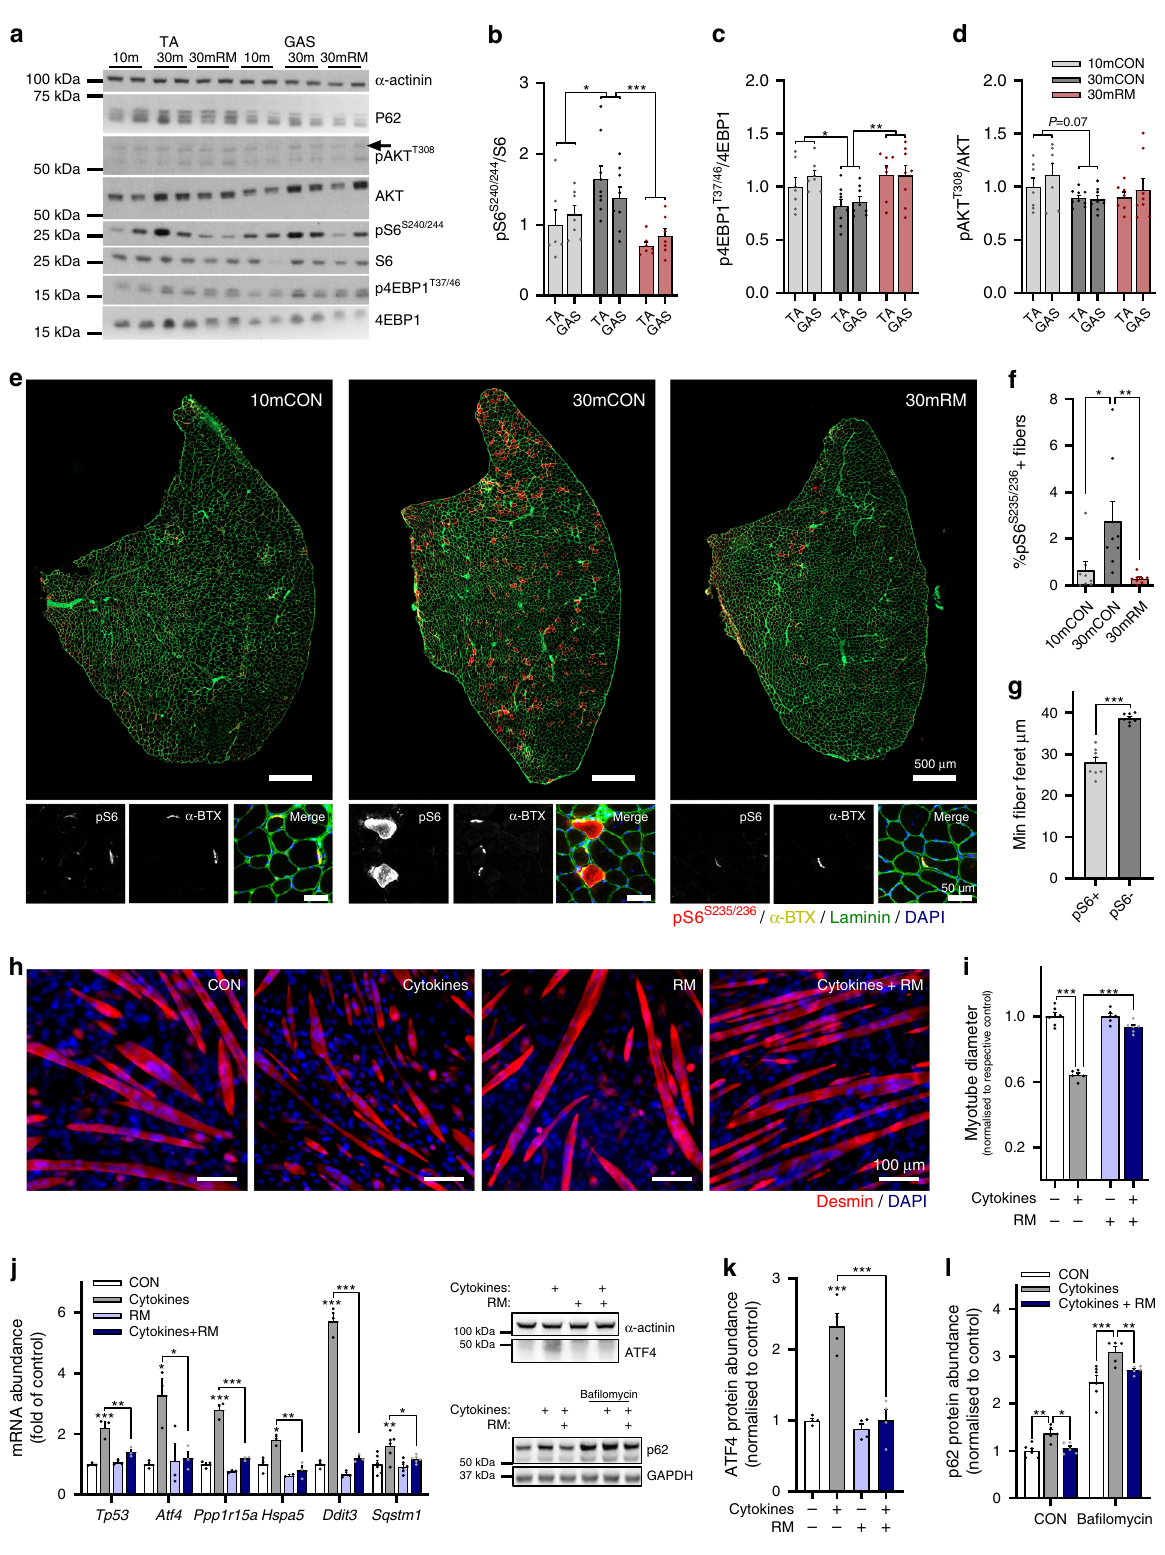
phosphorylated to total 4EBP1 was signi fi cantly lower in 30mCON than 10mCON mice, while rapamycin restored the ratio (Fig. 3c). There was a tendency for lower pAKT/AKT (Fig. 3d) and higher p62 (Supplementary Fig. S6A) protein levels in 30mCON compared to 10mCON mice, but rapamycin did not signi fi cantly affect these parameters. However, no